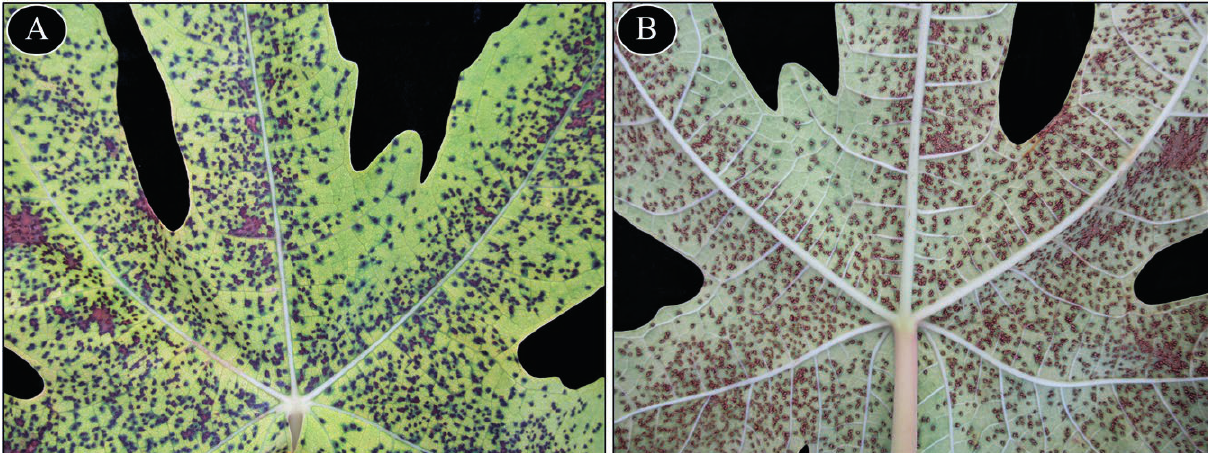
Figure 7. Fig rust symptoms on adaxial (A) and abaxial (B) leaf surfaces of the fig cultivar Brunswick, 50 d post inoculation of the abaxial surfaces with urediniospores of Phakopsora nishidana .